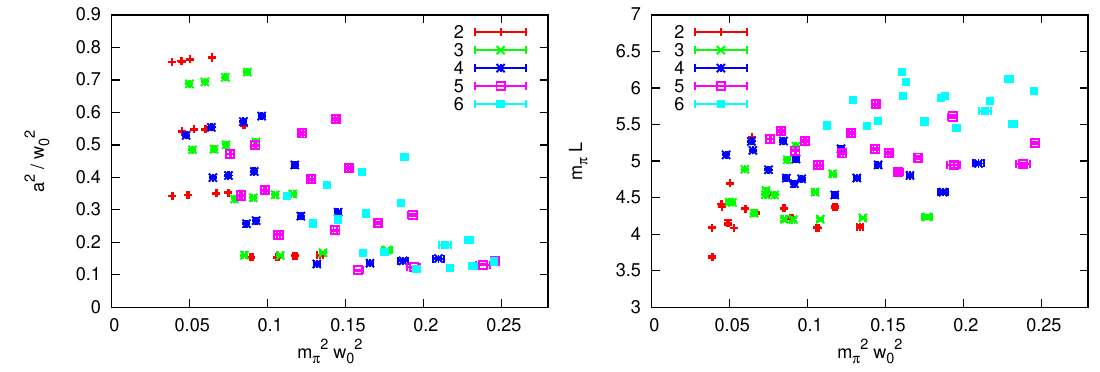
Figure 1 . The landscape of simulation points for the various (cid:13)avor numbers N f . Left: cut-o(cid:11) and Goldstone mass. Right: volume and Goldstone